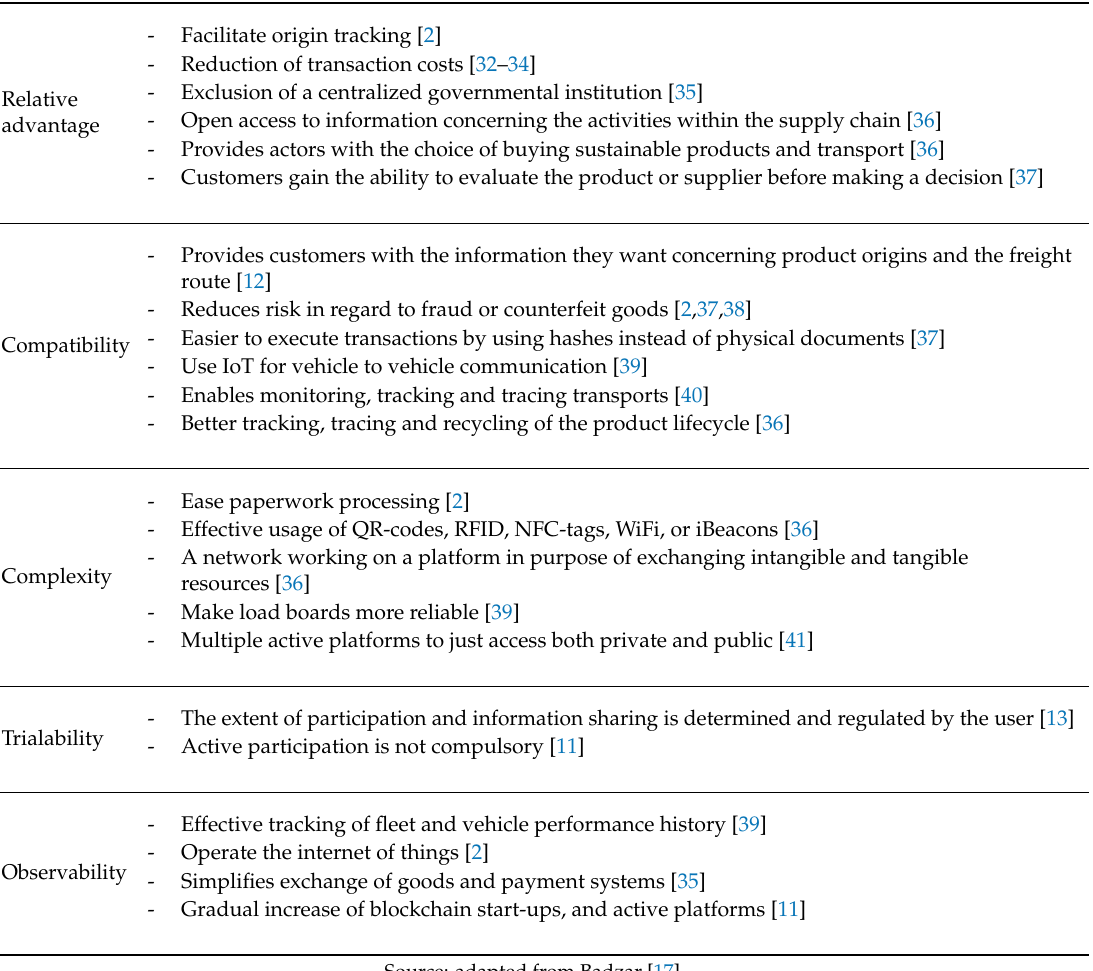
Table 3. Potential blockchain applications in the logistics